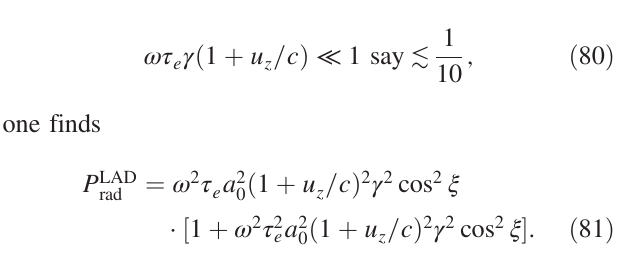
FIG. 15. P , P , and P plotted vs time t for a sinusoidal- ext rad kin envelope circularly polarized laser with parameters given in Fig. 12.